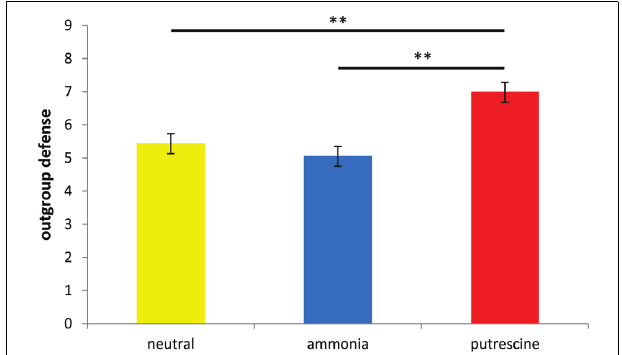
FIGURE 3 | Mean scores on the worldview defense scale for all three conditions (Experiment 4). Higher scores reflect greater hostility toward the target. Asterisks denote two groups differ at ** p <